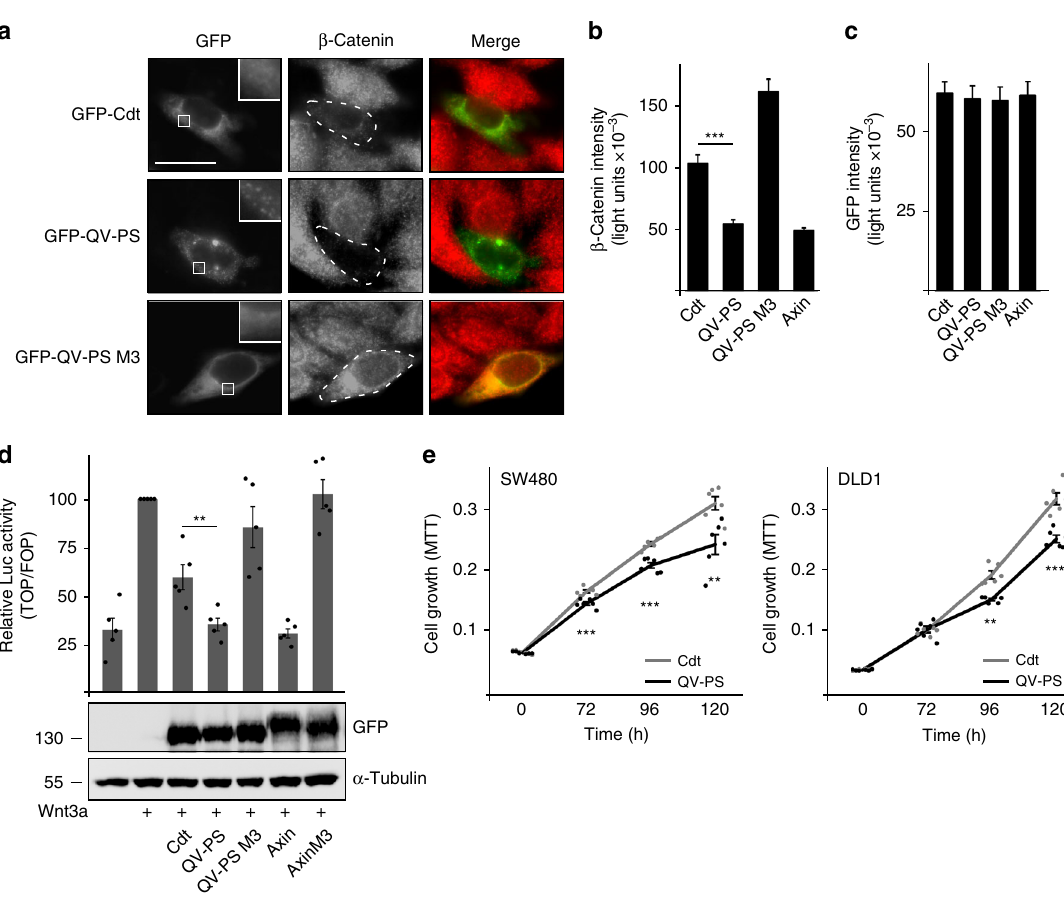
Fig. 4 Loss of RGS aggregation increases inhibition of Wnt/ β -catenin signaling by conductin. a Immuno fl uorescence staining of endogenous β -catenin (red) in SW480 cells transfected with indicated GFP-tagged constructs (green). In GFP panels, insets are shown enlarged at the upper right. Dashed lines mark transfected cells. Scale bar: 20 µ m. b Quanti fi cation of β -catenin fl uorescence intensities in one out of fi ve representative experiments as in a . Results are mean ± SEM ( n = 50). c Quanti fi cation of GFP intensities in cells analyzed in b . Results are mean ± SEM ( n = 50). Data distribution is shown in Supplementary Fig. 7. d Upper panel: Luciferase activity (TOP/FOP) in HEK293T cells transfected with indicated plasmids without or with ( + ) Wnt3a treatment. Results are mean ± SEM ( n = 5). Lower panel: Western blotting for GFP in extracts of HEK293T cells which were transfected with indicated GFP-tagged constructs at equal ratios as for the luciferase assay, and lysed directly in SDS-containing sample buffer due to differences in protein solubility. Loading control: α -tubulin. e MTT absorbance re fl ecting the number of viable SW480 (left panel) or DLD1 cells (right panel) expressing GFP-tagged conductin (Cdt, gray line) or the QV-PS mutant (black line) 0, 72, 96, and 120 h after seeding. One out of three representative experiments is shown. Results are mean ± SEM of six replicates ( n = 6). ** p < 0.01, *** p < 0.001 (Student ’ s t -test). Source data are provided as a Source Data fi